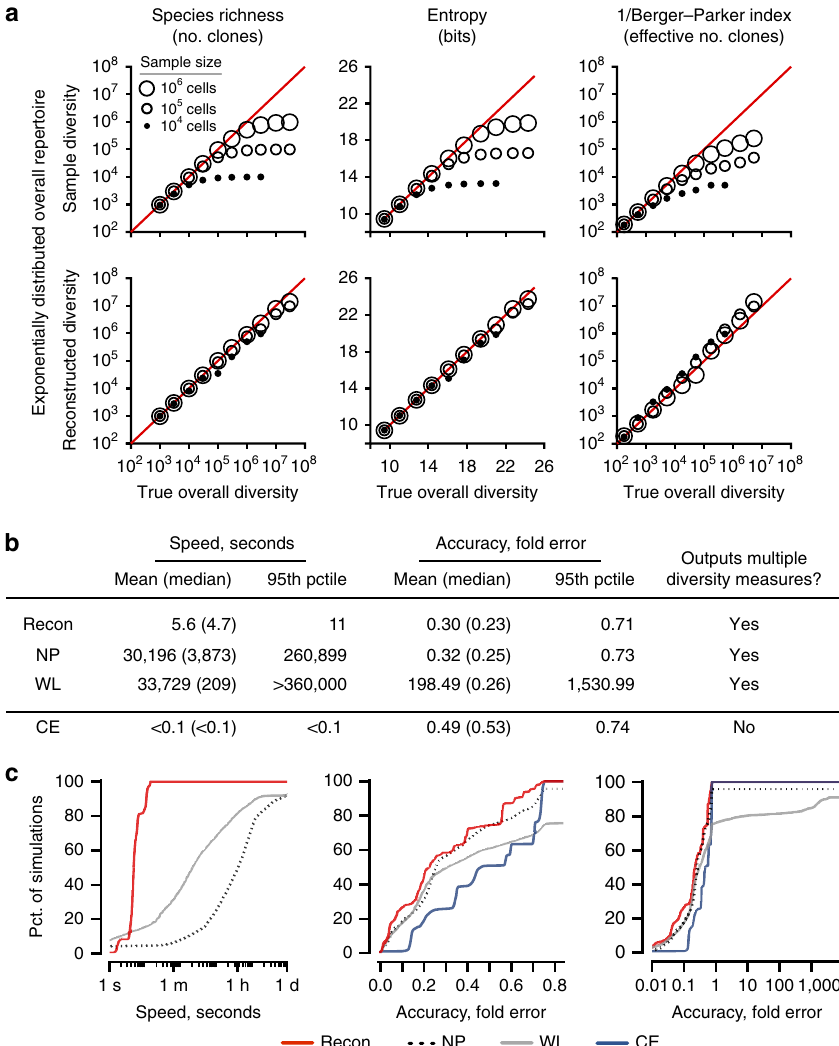
Figure 2 | Comparison of diversity estimates. ( a ) Sample diversity (top) and Recon’s estimate (bottom) of overall diversity versus true overall diversity for three different sample sizes—10,000 cells (filled circles), 100,000 cells (small open circles) and 1 million cells (large open circles)—for a representative gold-standard distribution without noise (shown in Supplementary Fig. 2e, left panel; see Supplementary Fig. 2 for additional examples). Coverage is defined as the number of cells in the sample divided by the effective number of clones in the overall population. Red line, unity (zero error). Left-to-right: species richness, entropy and the inverse Berger–Parker index. ( b ) Performance summary of Recon versus two other state-of-the-art methods for estimating any overall diversity measure (NP and WL) as well as a method for estimating only species richness (CE) on 3,200 noisy distributions, 100 realizations of noise for each of 32 combinations of exponential and multimodal distributions (Methods), coverage (0.05–0.3x) and overall diversity (100,000 to 3 million clones in the overall population). ( c ) Cumulative distribution of performance for distributions in b showing Recon is much faster than NP and more accurate than WL, which could be off by orders of